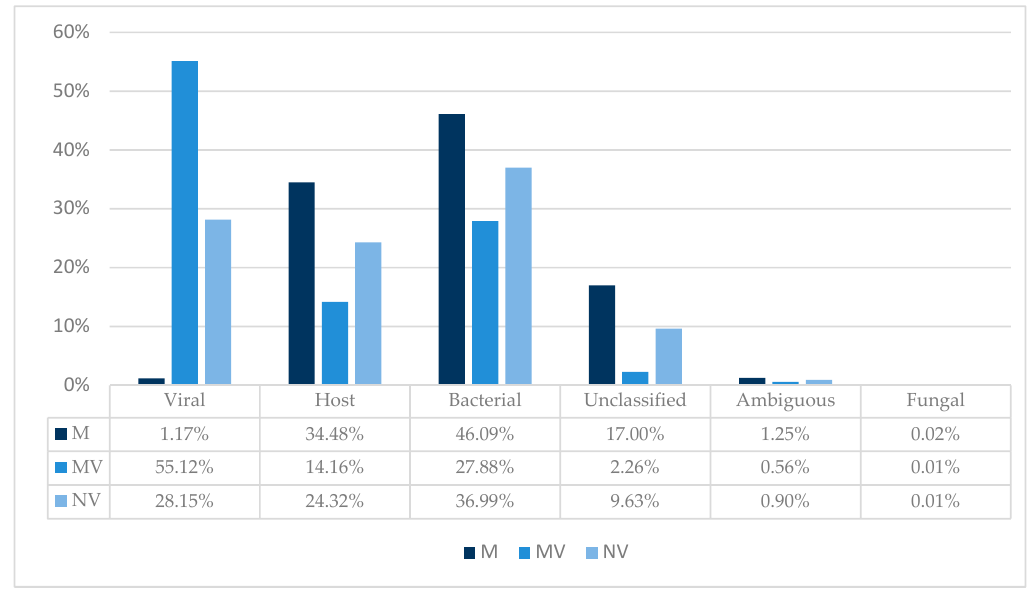
Figure 2. Sample composition with and without TSC on the ONT MinION and with TSC on the Illumina NextSeq. Abbreviations: M, MinION; MV, MinION with ViroCap; NV, NextSeq with ViroCap.